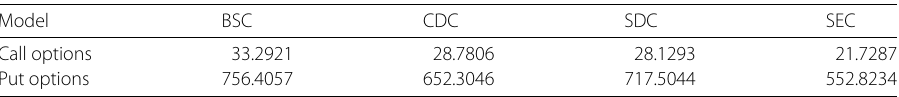
Table 2 Mean squared errors of call option prices obtained by four different models for the Standard and Poor 500 option prices Model Call options